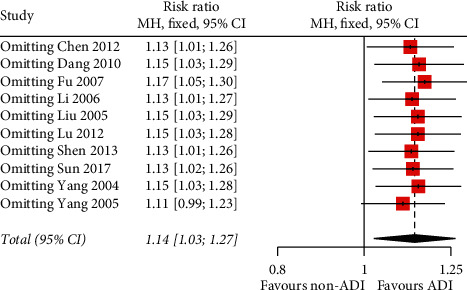
Sensitivity analysis showing that the result had good stability.